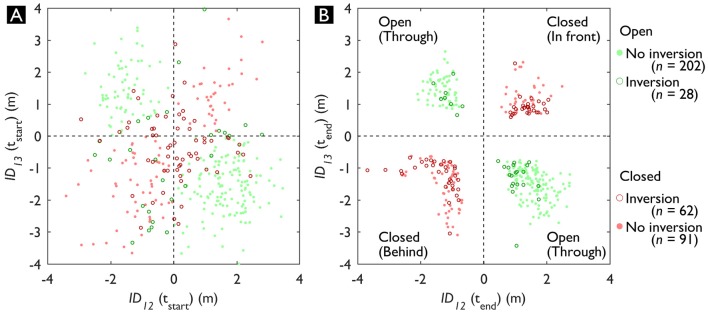
Distribution of the Interaction Distance (ID) in the triadic trials to both Walker 2 (W2) and Walker 3 (W3) at tstart
(A) and tend
(B). The colors indicate the final crossing order, the open circles indicate trials with a Dynamic Gap (DG) inversion. The dashed horizontal and vertical lines indicate the border between crossing in front and behind the other walker. When crossing behind both W2 and W3 (IDs < 0 m) or in front of both W2 and W3 (IDs > 0 m), the gap between them is closed for Walker 1 (W1). See also Video 2 of the Supplementary Material for an animated display from tstart until tend.